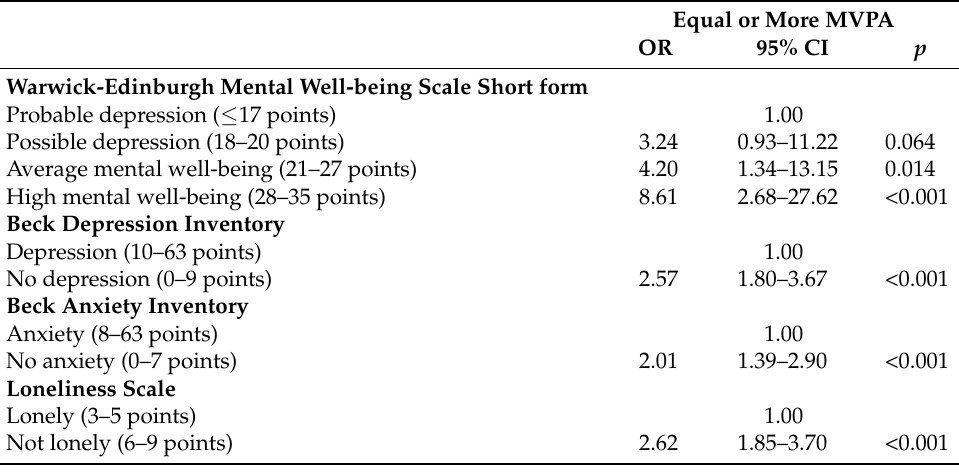
Table 5. Association between change in physical activity and psychological factors. Results are adjusted for age, gender, marital status, employment, household income, current smoking, current alcohol consumption, diagnosed chronic physical or mental illnesses. MVPA= moderate to vigorous physical